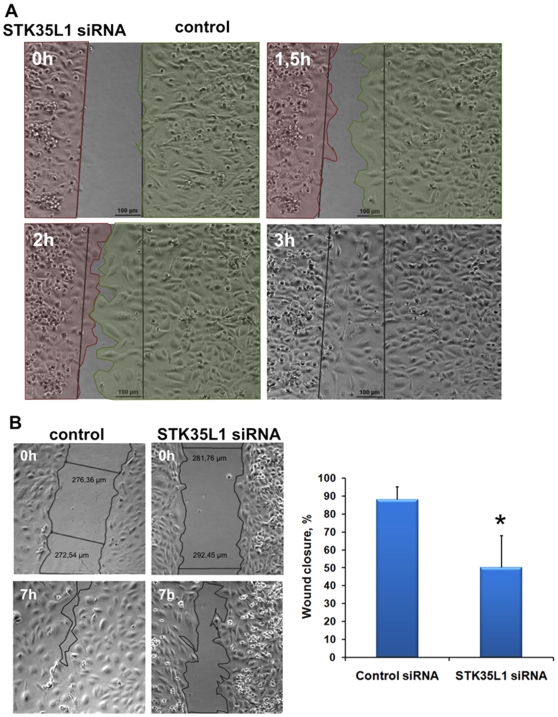
STK35L1 is required for endothelial cell migration.A) Migration assay using the IBIDI insert. Endothelial cells transfected with STK35L1 siRNA (red shaded part) or control siRNA (green shaded part) were seeded into different reservoirs of an IBIDI insert. After 8 hours the insert was removed and the closure of the gap was observed by video microscopy. The pictures from one experiment representative of three are shown, Scale bar 100 µm. B) Migration after mechanical injury. Left panel, representative micrographs, cells treated with control siRNA, or cells treated with STK35L1 siRNA are shown immediately 0 hr or 7 hr after mechanical injury; width of the wound is shown in µm. Right panel, Bar diagram, wound closure was quantified as described in the method section. Values are mean ± S.E. of three independent experiments; ‘*’, p<0.05.